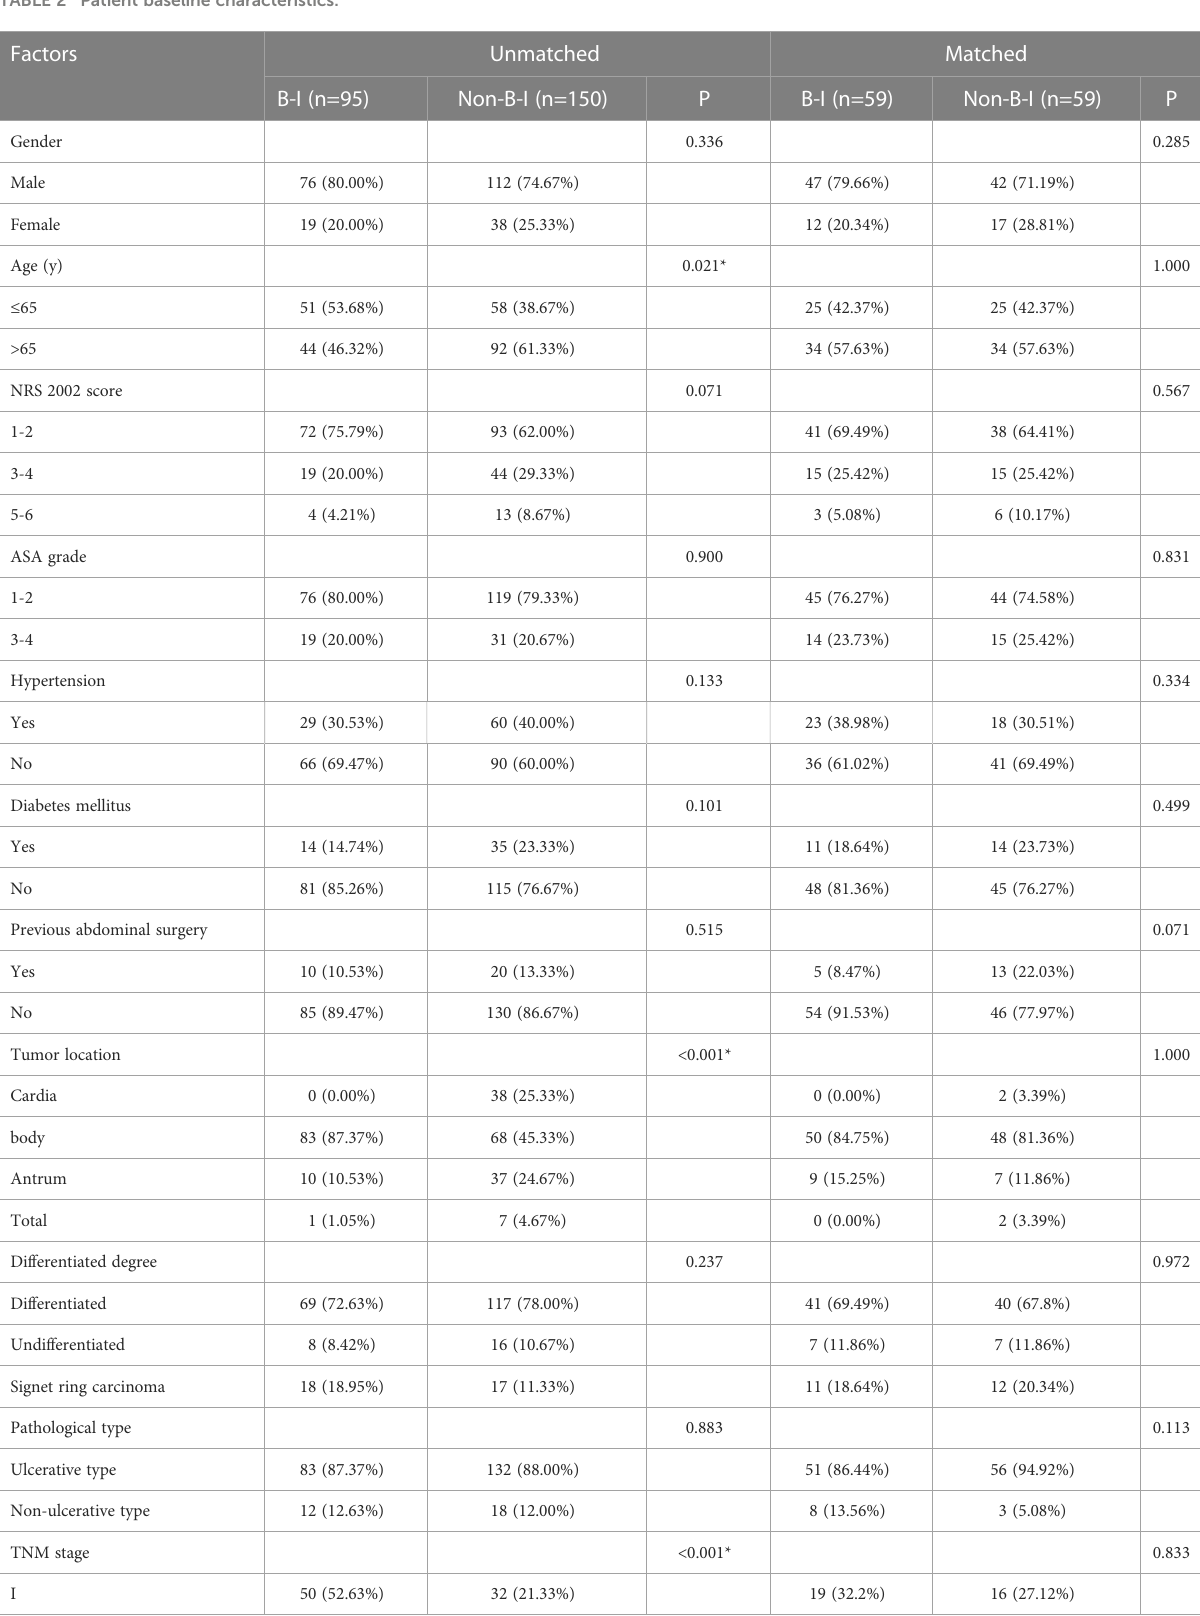
TABLE 2 Patient baseline